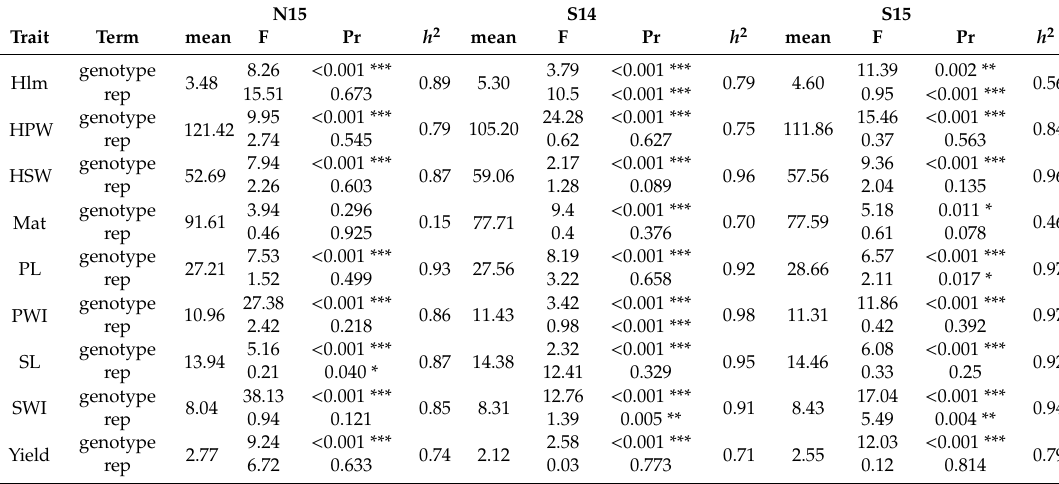
The relative di ff erence compared to Fleur11 ranged from − 13.1% to − 36.0%, corresponding to − 7.7 g and − 21.3 g,